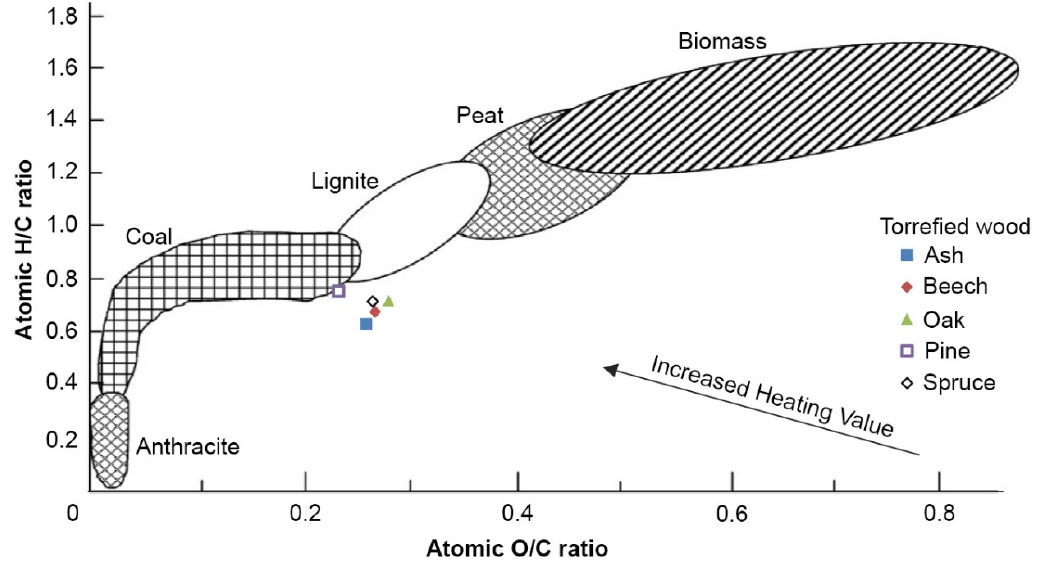
Figure 6. Graphic representation of the tested samples in a Van Krevelen diagram (based on Prins et al. [44]).